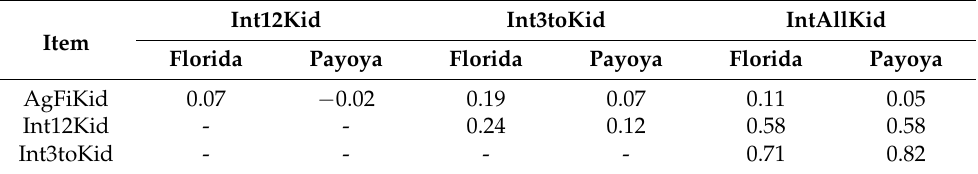
Table 4. Estimates of genetic correlations among fertility traits in Florida and Payoya breeds 1 .